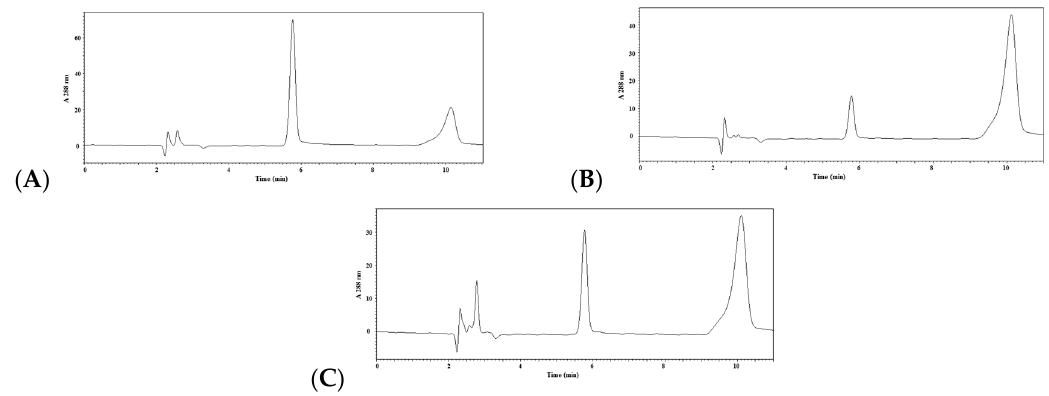
Figure 3. RP ‐ HPLC chromatograms of: blank control ( A ); lisinopril at 2 × 10 − 9 mol/L ( B ); and NPATY at 0.048 mg/mL ( C ) detected at 228 nm. Hippuric acid (HA) and hippuryl ‐ L ‐ histidyl ‐ L ‐ leucine (HHL) standard eluted out at 5.5 and 9.2 min.